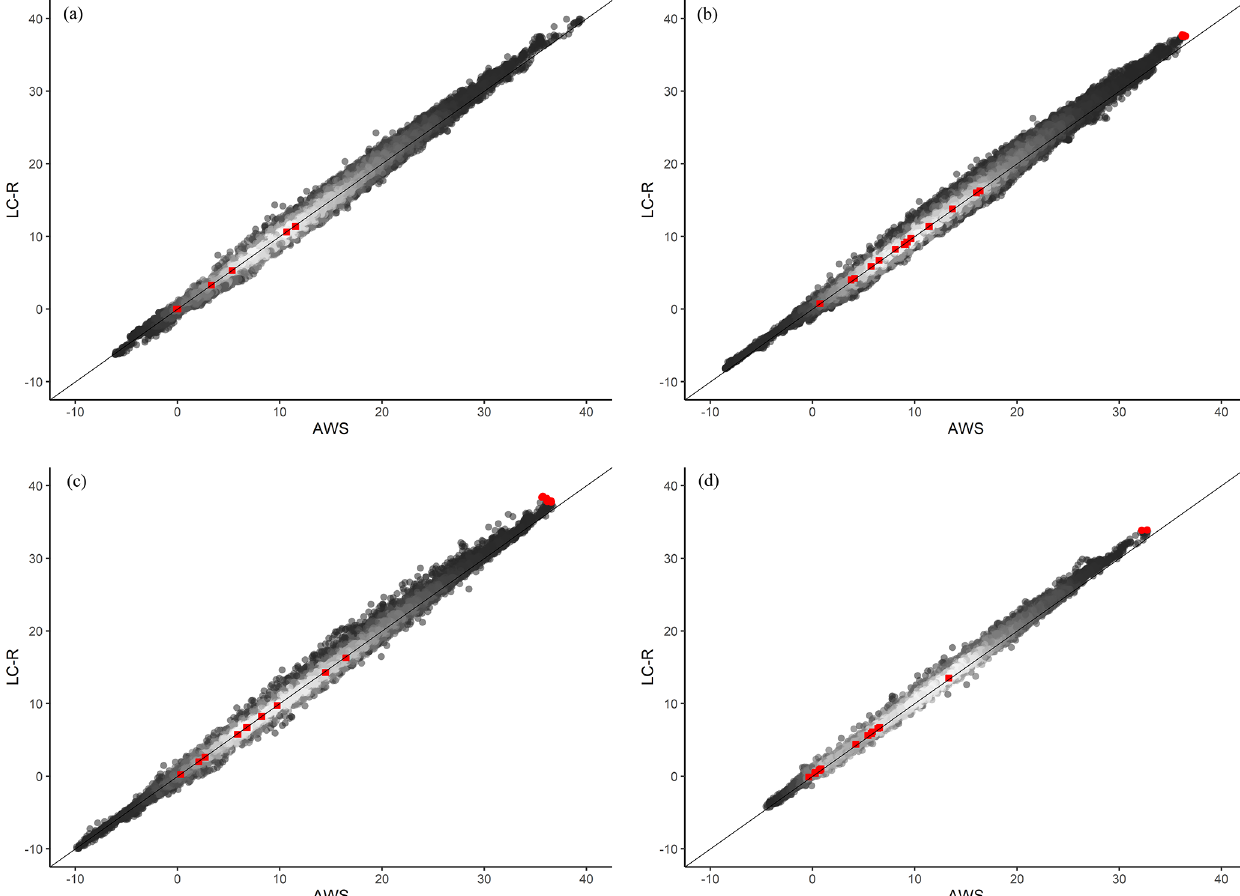
Figure 8. Scatterplots of LC-R versus AWS temperature for each reference station, (a) LC-R01, (b) LC-R02, (c) LC-R04 and (d) LC-R05, at QC level 0. Observations defined as range outliers are symbolised by a red circle, and temporal outliers are symbolised by a red square. The identity line is shown in black. The colour scale indicates the density of observations, with white indicating the highest and black indicating the lowest. The scatterplots include all measurements between the installation date of each LC-R and December 2021.